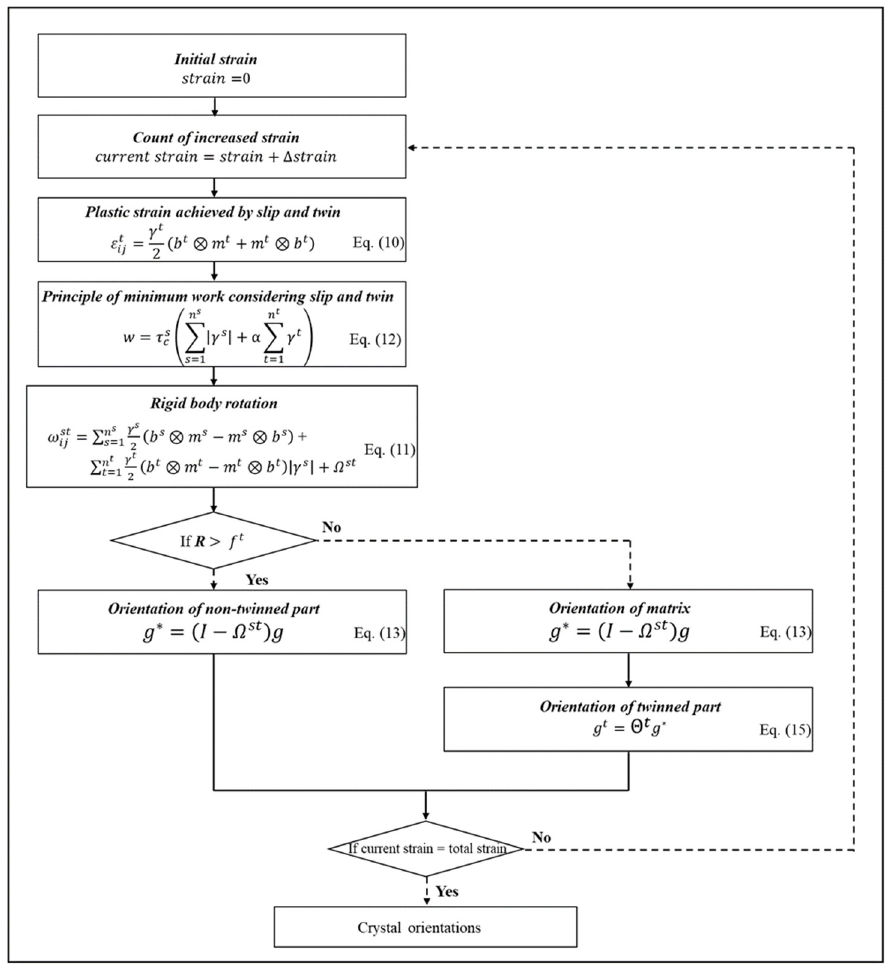
Figure 1. Flowchart of subroutine in MT-model.